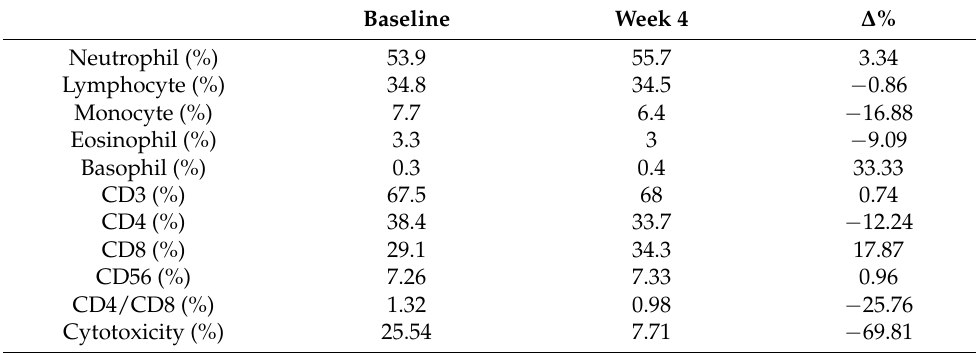
Table 3. Changes in granulocytes and